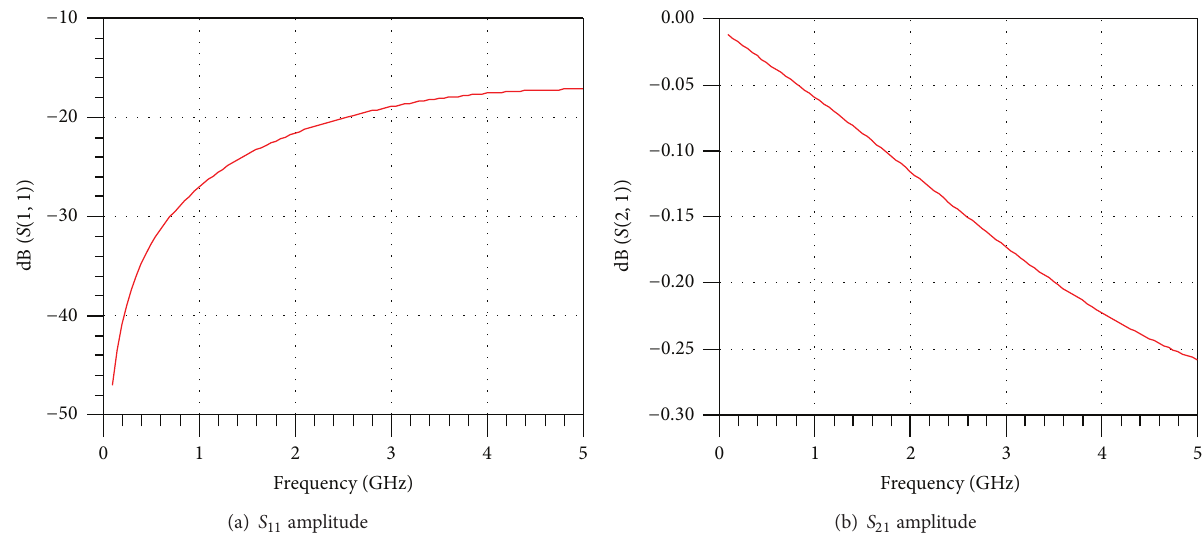
Figure 26: Simulation results of line 1.